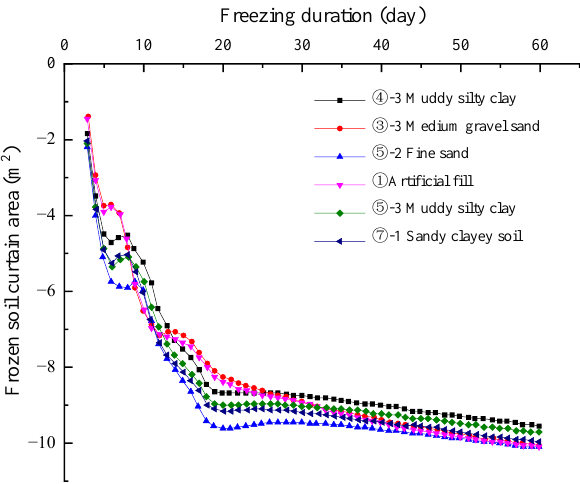
Figure 12. The average temperature of frozen soil curtain in different soil